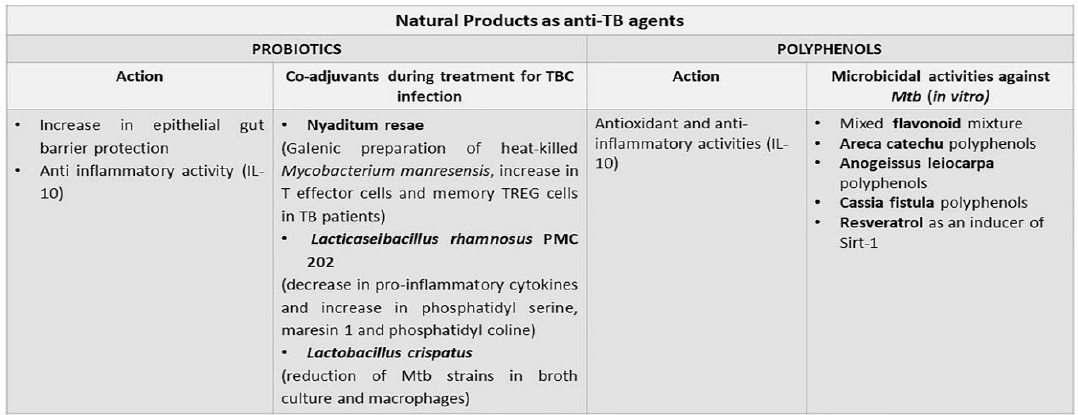
Figure 3. Potential use of natural products as anti ‐ TB agents. Both probiotics and polyphenols have been experimented with as anti ‐ TB pharmaceuticals. Probiotics can modulate the gut–lung axis that been experimented with as anti-TB pharmaceuticals. Probiotics can modulate the gut–lung axis that is compromised in the course of TB. Polyphenols exert anti ‐ TB microbicidal activity in vitro and is compromised in the course of TB. Polyphenols exert anti-TB microbicidal activity in vitro and their their application in human TB needs to be better explored. application in human TB needs to be better